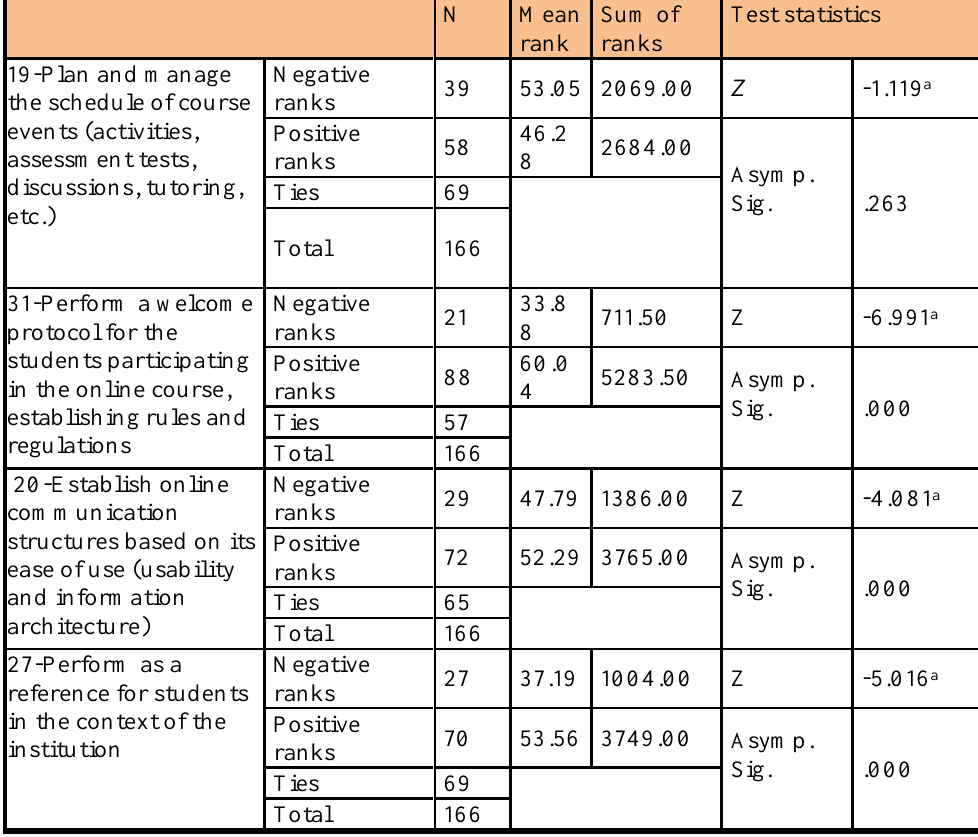
Wilcoxon Signed Ranks Test. Median Difference on the Level of Proficiency and Professional Development Needs Regarding the Managerial Role Competencies Applied to Online